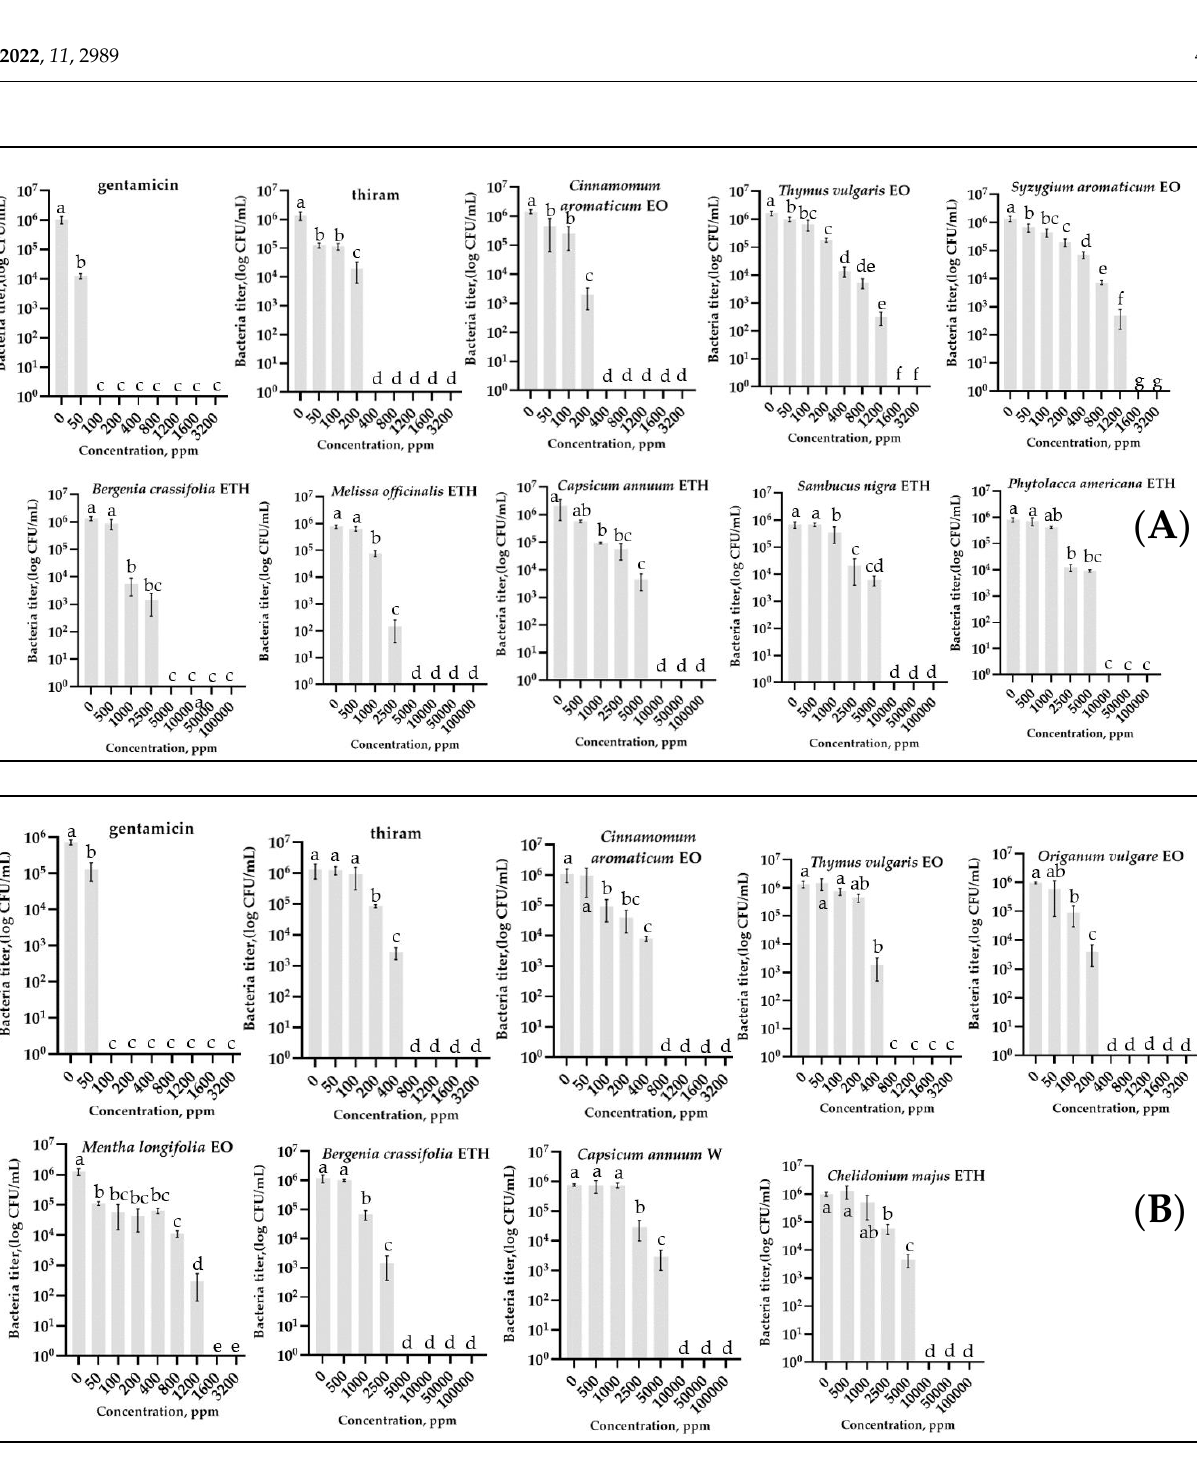
Figure 1. Effect of different concentrations of essential oils and plant extracts on growth of Pseudomonas savastanoi pv. glycinea strain G2 ( A ) and Curtobacterium flaccumfaciens pv. flaccumfaciens strain F-125-1 ( B ), measured by counting colonies on agar medium after cultivation in liquid medium. Concentrations are expressed in ppm. EO—essential oil, ETH—ethanolic extract, W—water extract. Values in panels represent the respective mean of two independent trials and error bars represent the standard deviation. Values within columns marked by different letters (a–g) have a significant difference, Duncan’s criteria, p = 0.05. A concentration of 0 indicates bacterial growth in the liquid medium without EOs, PEs, standard antibiotics, and thiram. The graphs show only variants with MBC <1600 ppm for essential oils and <10,000 ppm for plant extracts.